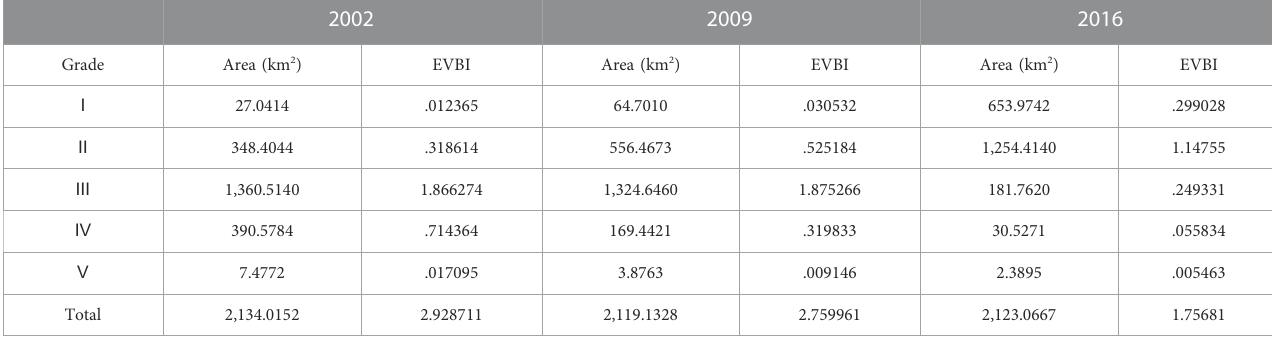
TABLE 4 Area and EVBI distribution of ecological vulnerability in different years in Zhongxian County,